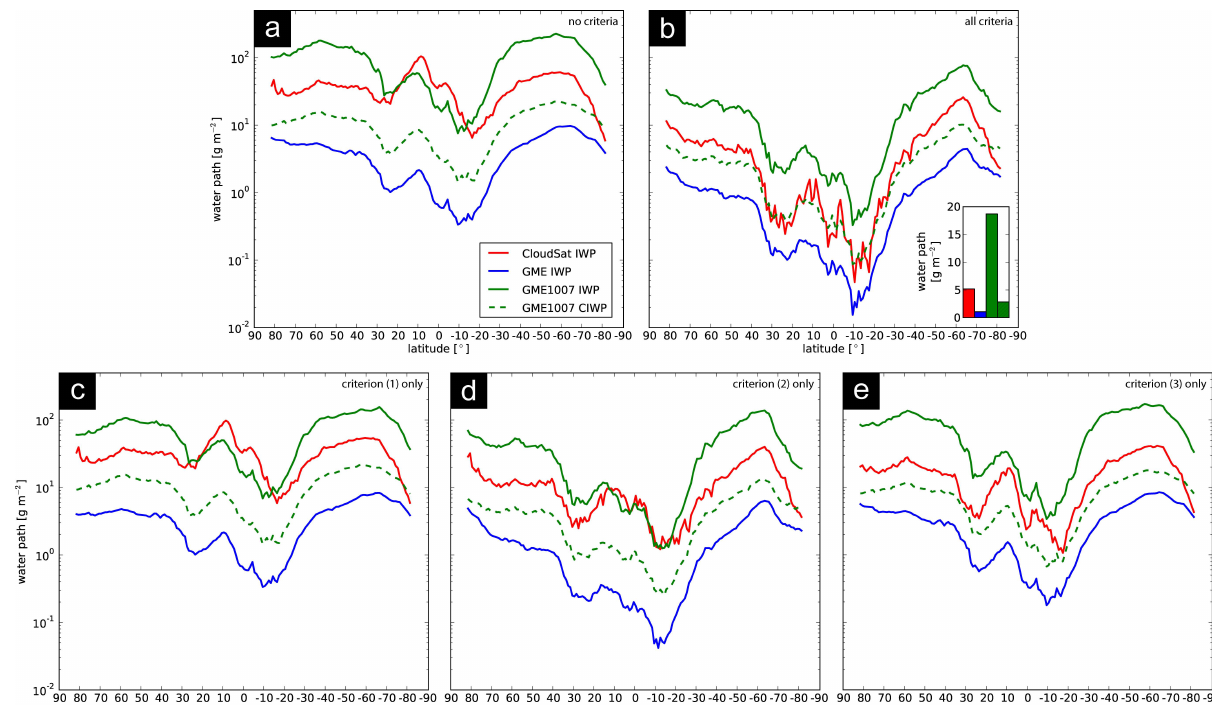
Fig. 4. Zonally averaged water paths for 1 July 2009 to 31 October 2009. Red: CloudSat; blue: GME; green: GME1007. Solid: IWP; dashed: CIWP. (a) no criteria, (b) all criteria, (c) Temperature criterion only, (d) convection criterion only, (e) cloud cover criterion only. Inset in (b) : globally averaged IWP. Averaged over total number of pixels and profiles,